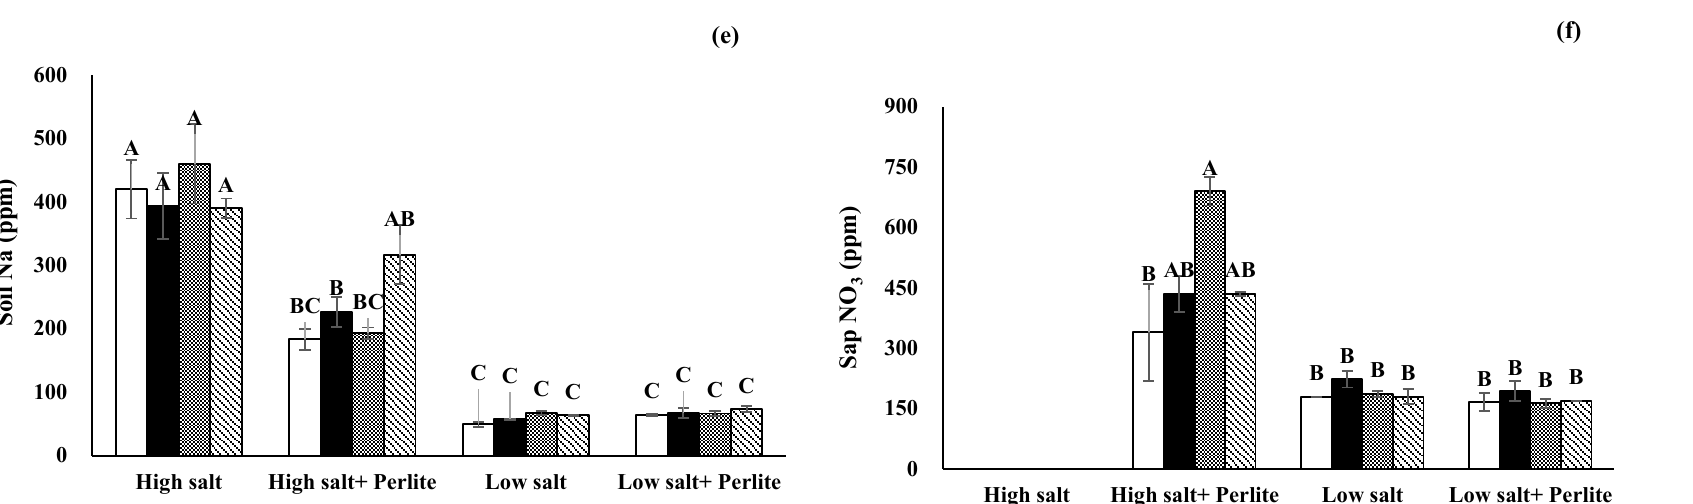
Figure 1. Effect of soil type and soil amendment on soil ( a ) pH, ( b ) EC, ( c ) phosphorus, ( d ) Si, ( e ) Na, and ( f ) plant sap NO 3 concentrations of cucumber ± S.E. C = control; BC = biochar; Si = silica; BC + Si = biochar + silica. Means sharing the same letters do not differ significantly at p <